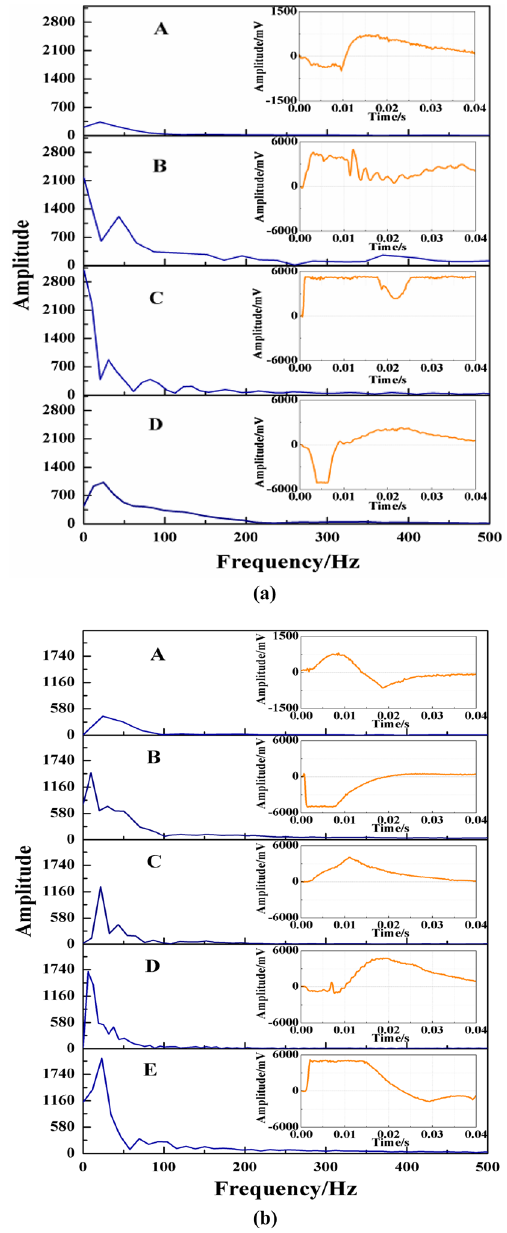
Fig. 14 The charge spectrum during coal under different loading path. a Grade loading. b Cyclic